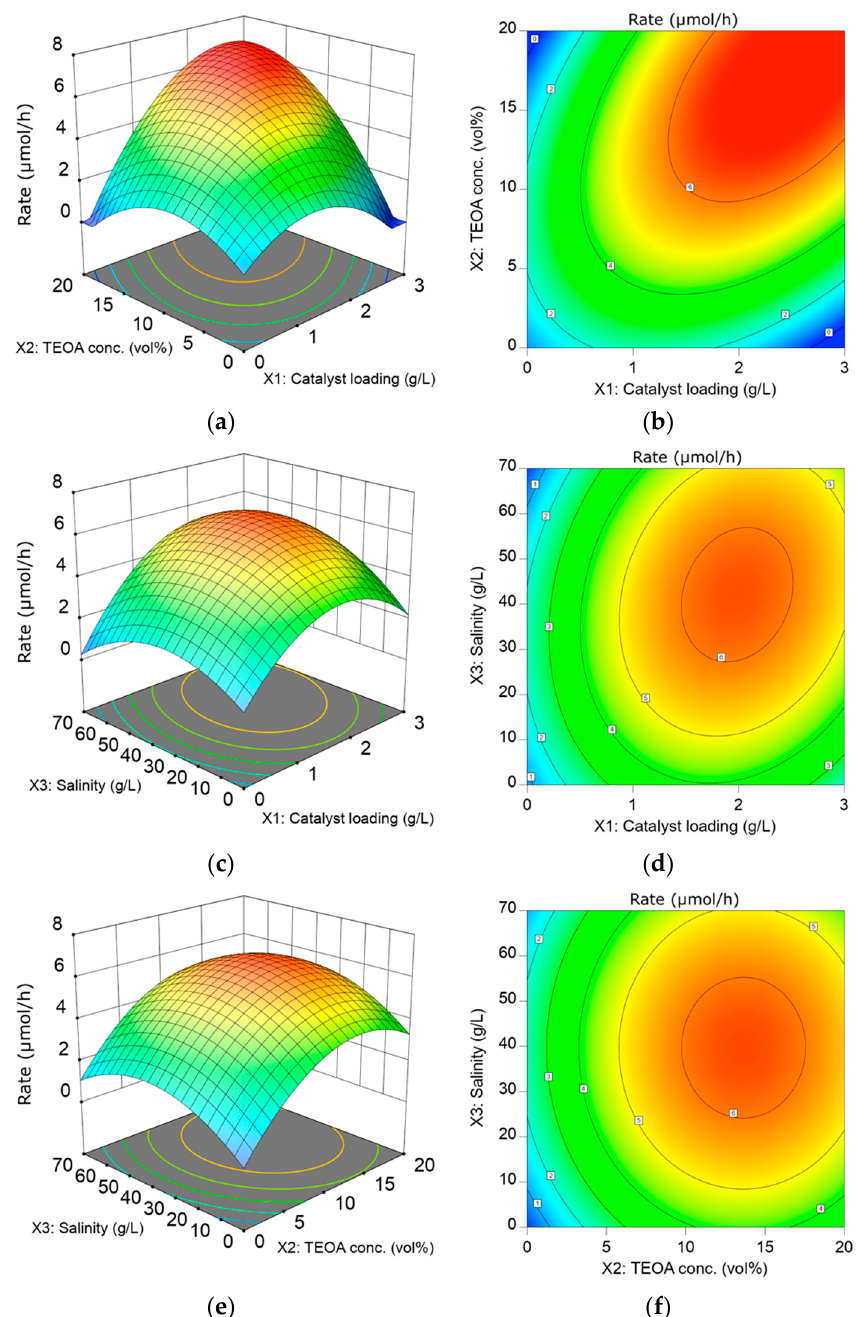
Figure 3. The 3D response surface plots and contour plots show the interaction between ( a , b ) catalyst loading and TEOA concentration; ( c , d ) catalyst loading and salinity; ( e , f ) TEOA concentration and salinity based on the HER rate with the controlled factor keep at level 0.